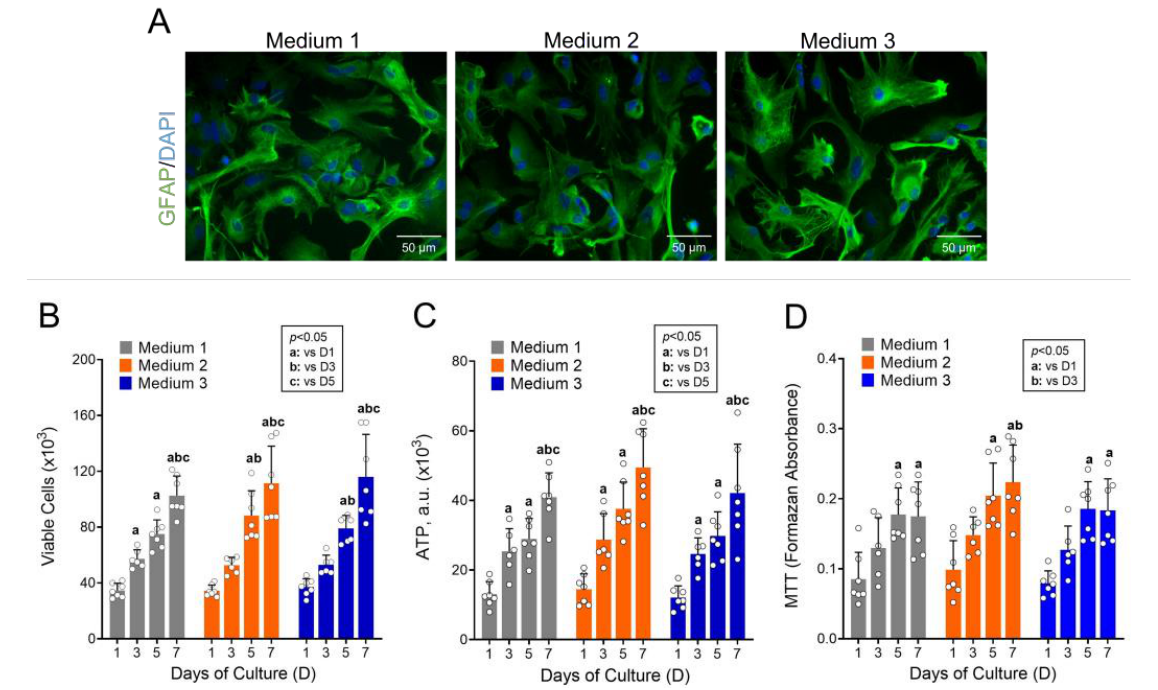
Figure 1. Proliferation and viability of astrocytes cultured in media containing different concentra- tions of energy substrates. Astrocytes were cultured in DMEM containing various concentrations of energy substrates, such as 25 mM glucose, 4 mM glutamine, and 1 mM pyruvate (Medium 1); 5.5 mM glucose, 4 mM glutamine, and 1 mM pyruvate (Medium 2); 5.5 mM glucose, 0.8 mM glutamine, and 0.3 mM pyruvate (Medium 3). Cells were analyzed after one (D1), three (D3), five (D5), and seven (D7) days in culture. ( A ) Microphotographs of astrocytes at D5 when cultured in Media 1, 2, and 3. ( B ) Cell viability by trypan blue. ( C ) ATP content in cultured cells. a.u.: Arbitrary units. ( D ) Cell viability by MTT. Statistically significant by two-way ANOVA, post-hoc Bonferroni ( p < 0.05); “a” compared to D1, “b” compared to D3, and “c” compared to D5 in the same medium. N = 6 – 7.